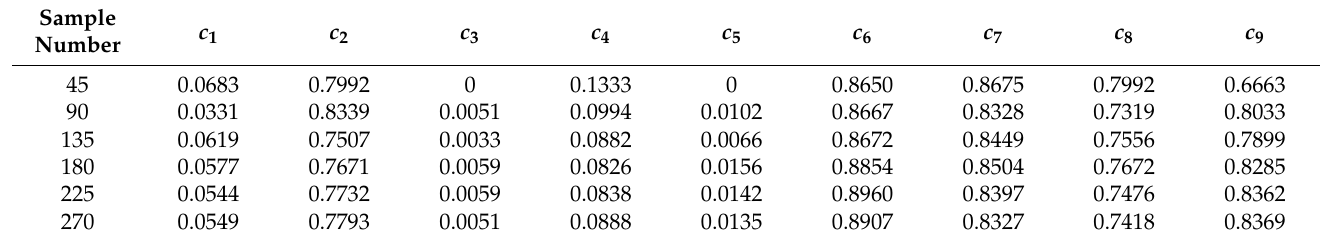
Table 8. The clustering center of fault type 1 (cid:13) under different sample